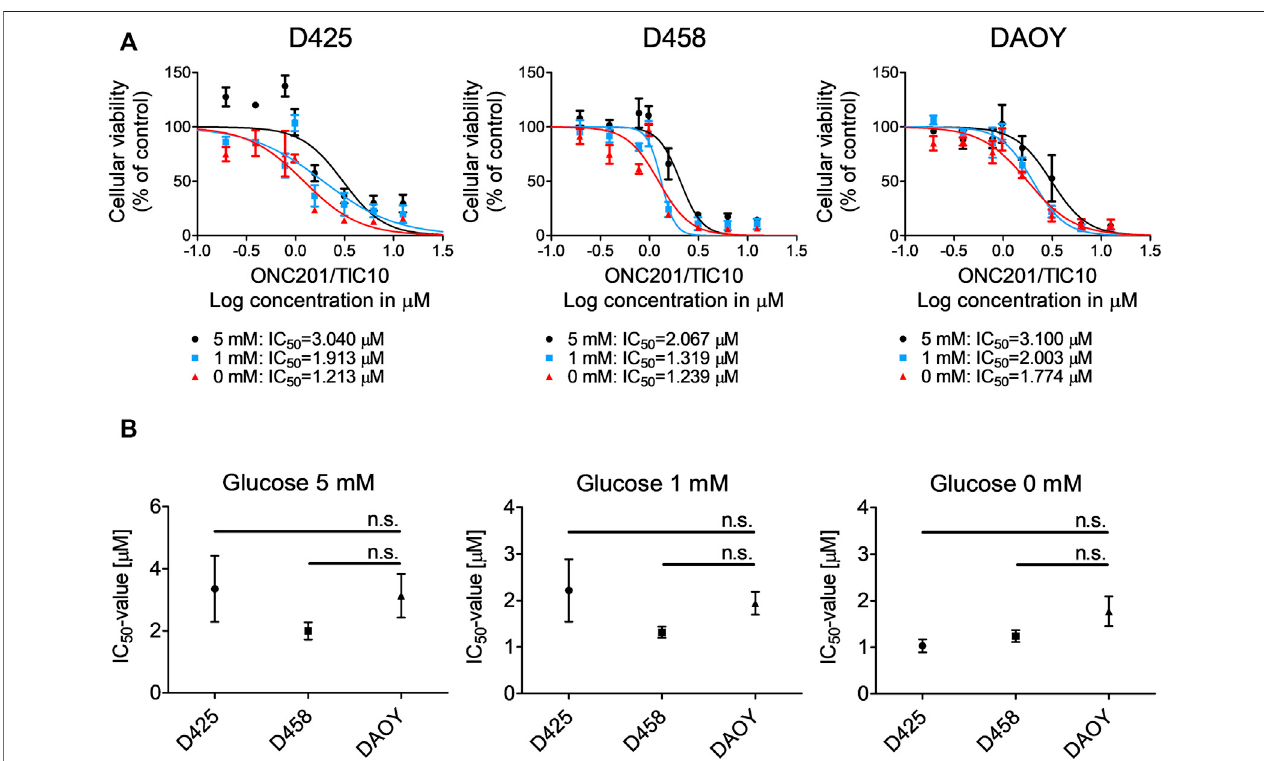
FIGURE4| GlucosestarvationsensitizesforONC201/TIC10. (A) ,D425,D458andDAOYcellsweretreatedwithsolventorincreasingconcentrationsofONC201/ TIC10 under serum starvation (1.5%FBS) and indicated glucose concentrations. Non-linear regression was performed and IC 50 -values were calculated. Data are presented as mean and SEM of three independent experiments. (B) , Quantitative representation of the IC 50 -values for indicated cells treated as described for A. Mean, SEM and n (cid:1) 3.